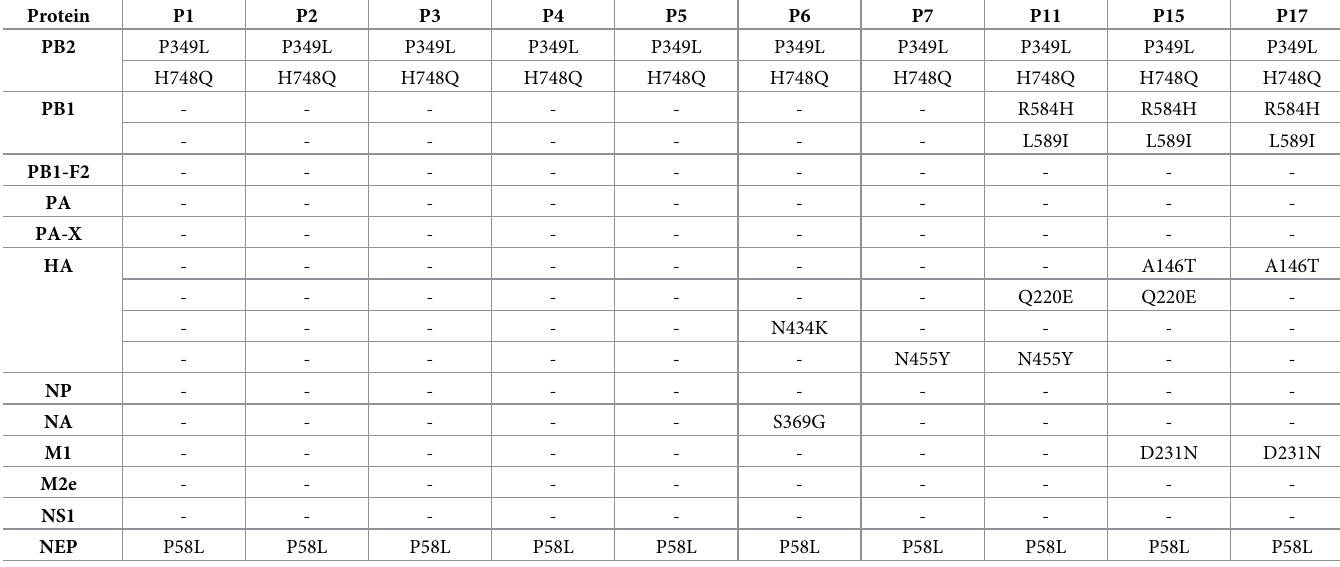
Table 3. Amino acid changes in the consensus H7N1 genome across passages (P), compared to the original LPAI H7N1 virus. Protein